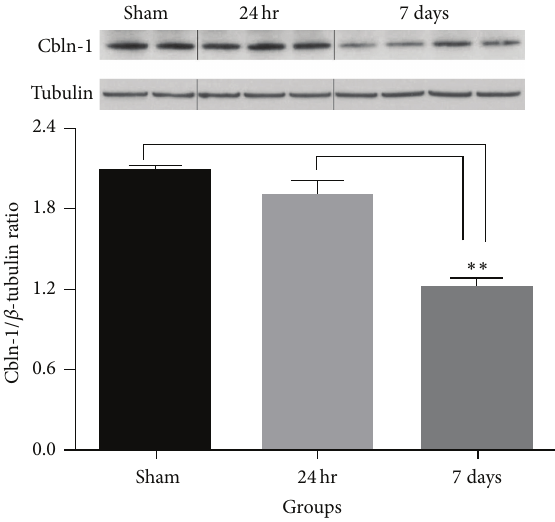
Figure 3: Western blot showing Clbn-1 levels in cerebellum of sham ad SCI animals at 24hr and 7 days following injury. Densitometric analysisrevealedthatCbln-1levelsweresignificantlyreduced( ∗∗ 𝑝 < 0.01 ) within 7 days after SCI relative to sham and the 24 hr survival time point. Bars represent group means ±